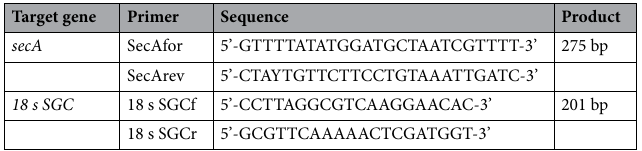
Table 3. List of primers and their sequences used in PCR